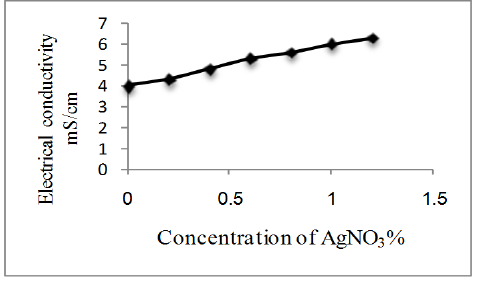
Fig. 5. Effect the (AgNO Conductivity of (Nylon 6).